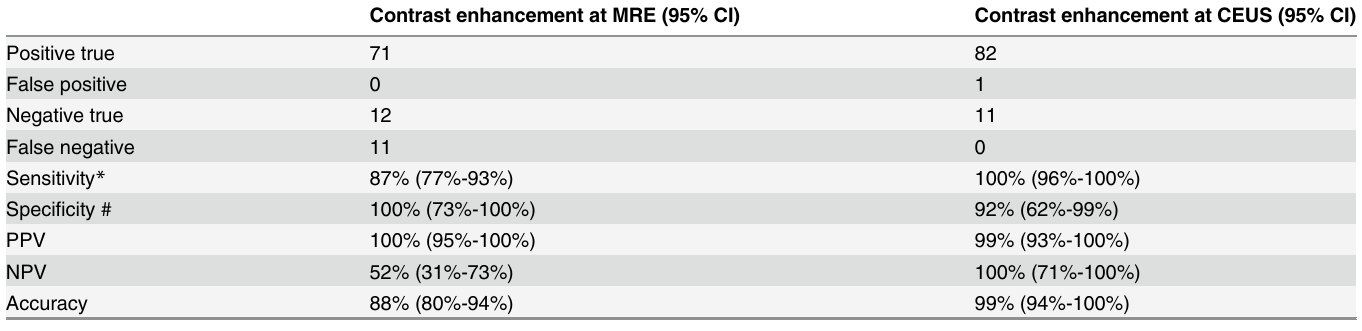
* P value for pairwise McNemar test was 0,01 for MRE versus CEUS # P value for pairwise McNemar test was 1.0 for CEUS versus MRE.